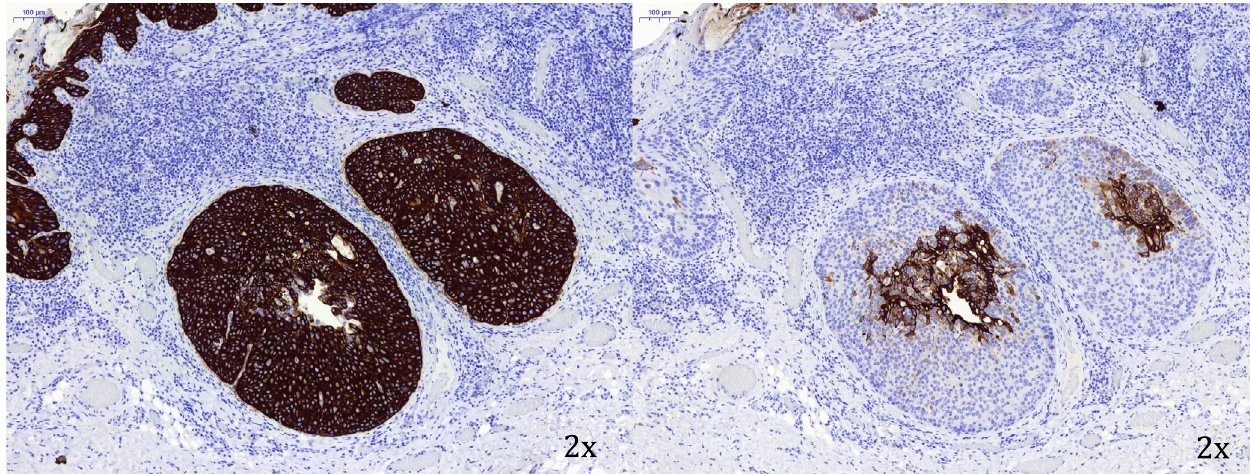
Fig. 5. Surgical specimen – LEFT: CK5/6 and RIGHT CK7 – showing the presence of two distinct